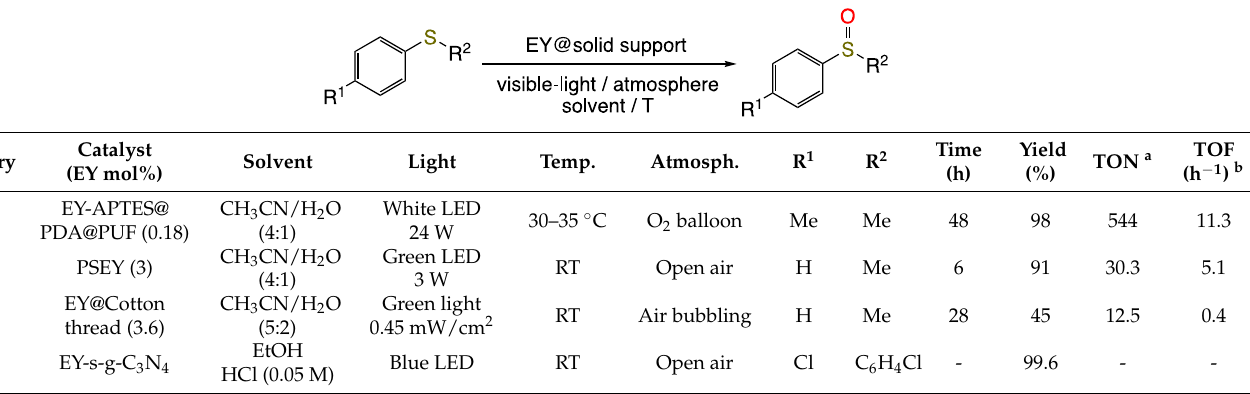
Table 3. Oxidation of sulfides under visible light irradiation using eosin Y heterogenized on various supports as photocatalyst.